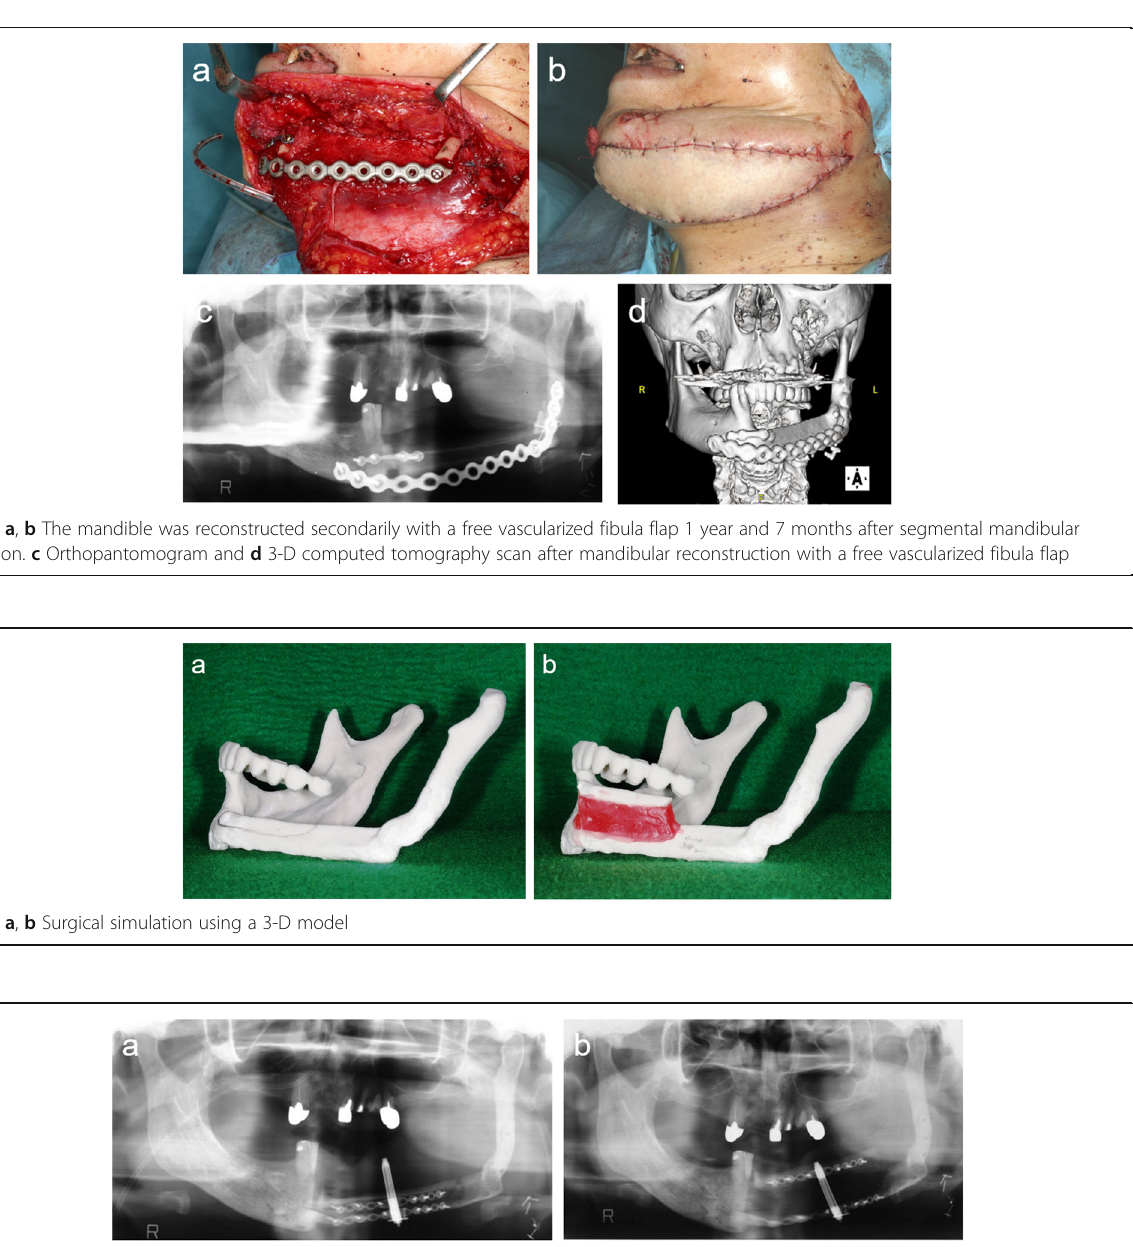
Fig. 11 Orthopantomogram a 1 day postoperatively and b at the end of distraction